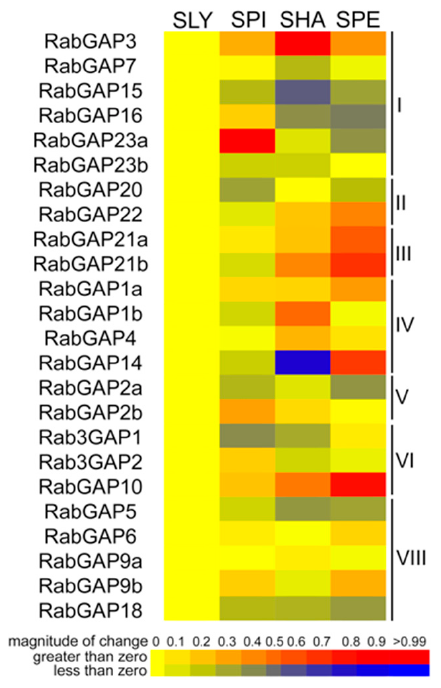
Figure 6. Expression profiling of RabGAP genes in wild tomato species. Transcript levels of RabGAP genes from wild tomato species relative to S. lycopersicum are represented. Higher or lower gene expressions are shown in red and dark blue, respectively. Nomenclature: SLY: S. lycopersicum , SPI: S. pimpinellifolium , SHA: S. habrochaites and SPE: S. pennellii . All values are detailed in Table S6.